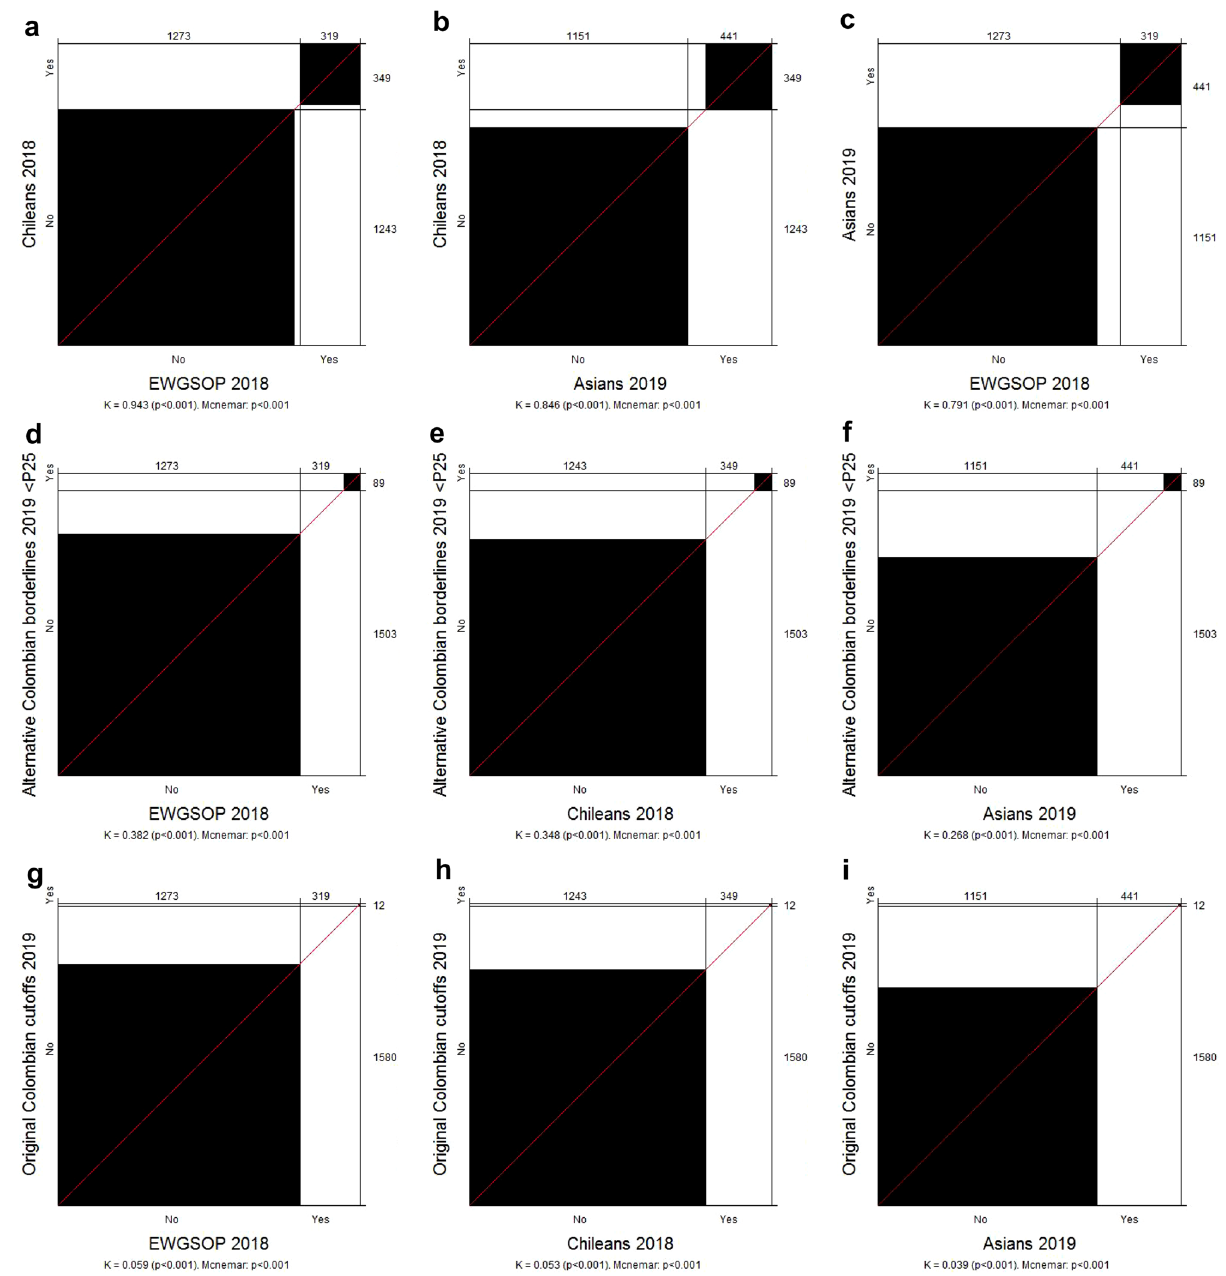
Figure 1. Agreement plot of dynapenia between different cutoff points. European consensus EWGSOP2 2018: European Working Group on Sarcopenia in Older People update in 2018 5 . Asian consensus 2019 11 . Chileans 2018: Reference values of handgrip dynamometry in older Chileans 13 . Original Colombian cutoffs 2019: reference cutoffs for handgrip strength among older adults 17 . Alternative Colombian borderlines2019 (< p25): values lower than the 25-percentile taken from Ramirez-Velez et al. 17 . K: Cohen’s Kappa Coefficient. McNemar: McNemar test. < p25: Values below 25